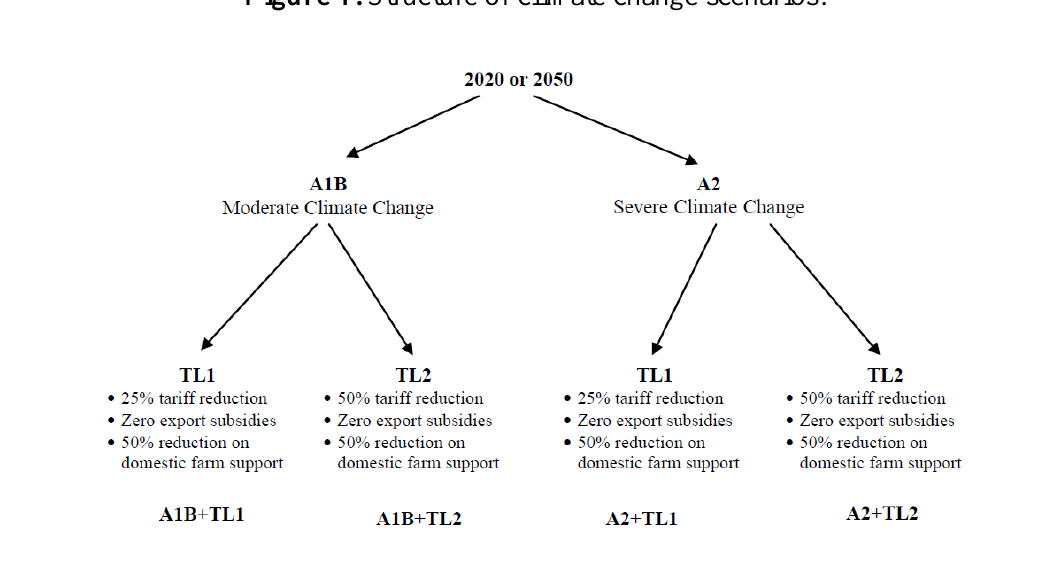
Figure 1. Structure of climate change